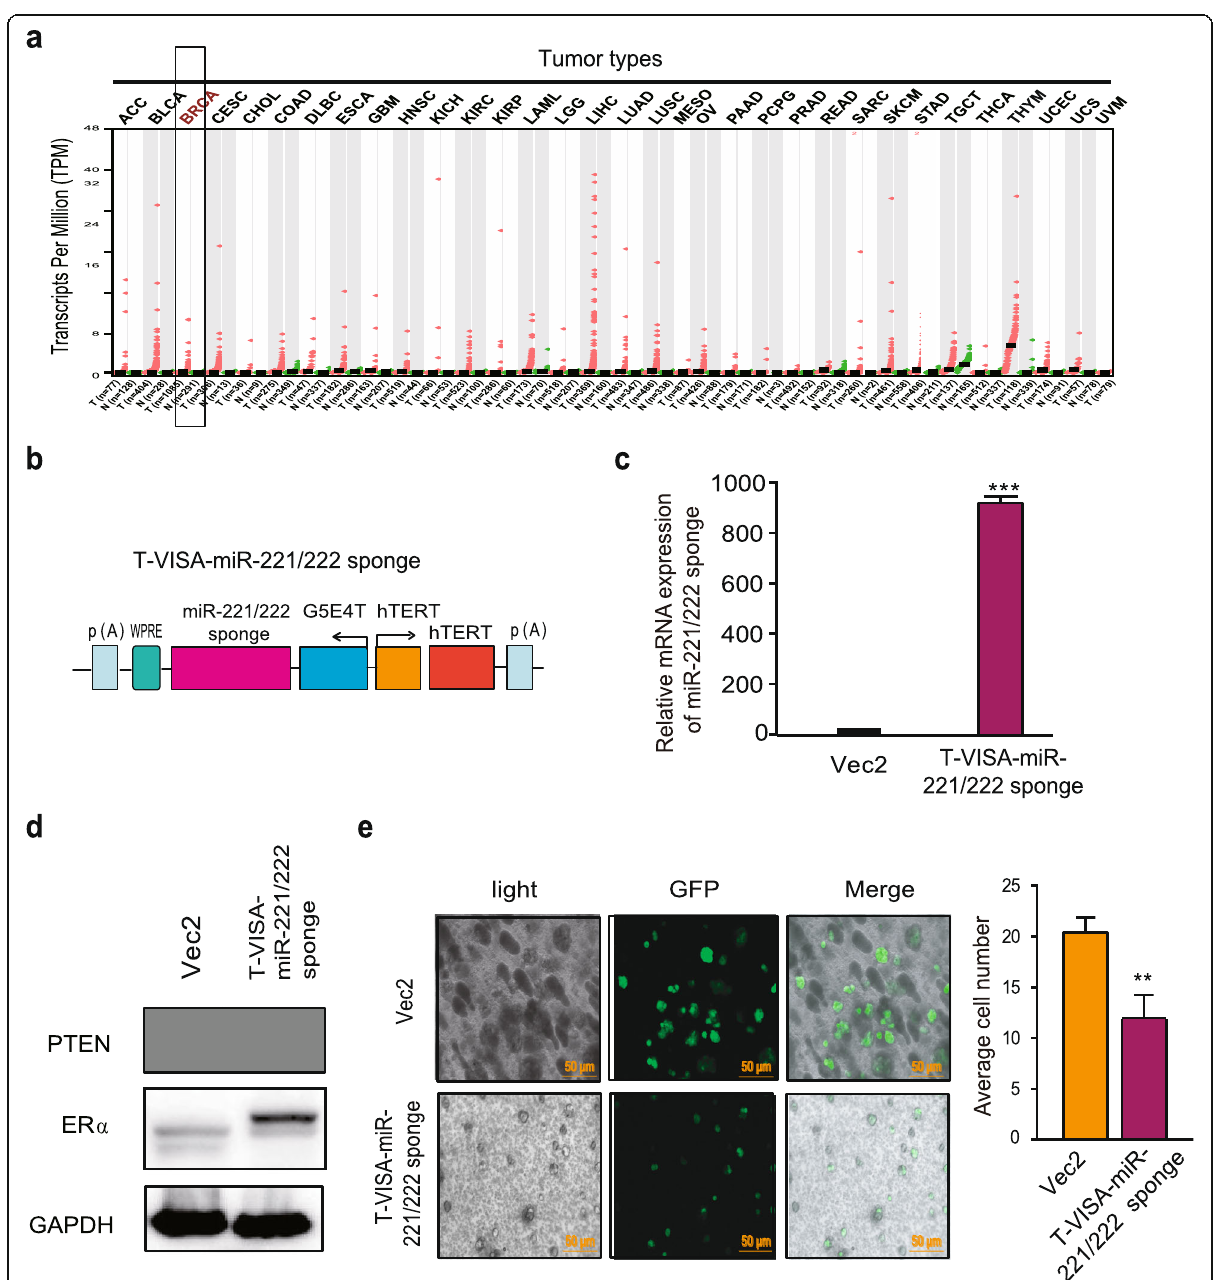
Fig. 4 T-VISA -miR-221/222 sponge inhibited cell growth of MCF-7 TamR cells in a 3D cell-culture model. a hTERT expression profile across all tumor samples and paired normal tissues. Each dot represents the expression in one sample. The red dots represent tumor samples, the green dots represent normal samples. T: Tumor, N: Normal. BRCA: Breast cancer. b Schematic representation of the hTERT-based promoter-driven miR- 221/222 sponge construct (T-VISA-miR-221/222 sponge). c The mRNA expression of the miR-221/222 sponge was analyzed by qRT-PCR after 48 hours transfection with the T-VISA-miR-221/222 sponge expressing vector. d The protein level of ER α and PTEN in MCF-7 TamR cells was determined by western blotting after 72 hours transfection with the T-VISA-miR-221/222 sponge expressing vector. e The effect of the T-VISA- miR-221/222 sponge on cell growth of the GFP-expressing reporter in MCF-7 TamR 3D cell culture. The data in c-e were presented as the mean ± SD ( n = 3). ** p < 0.01, *** p <